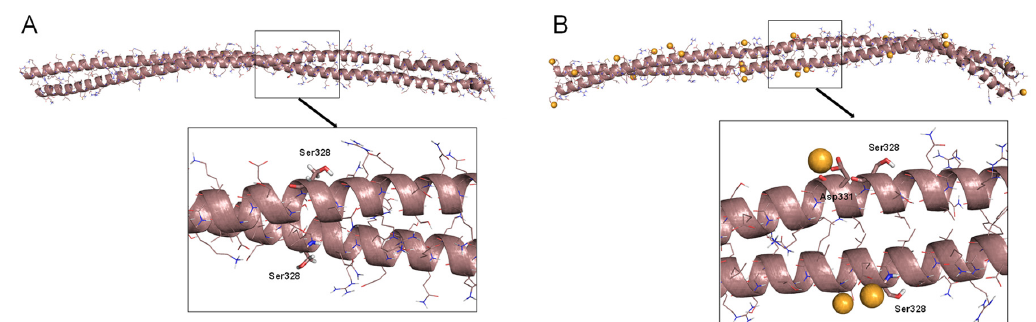
Figure 3. Dimer B of a vimentin Cys328Ser mutant and its interaction with zinc. ( A ) Final snapshot of a 100 ns MD simulation of the Cys328Ser mutant in water. ( B ) Final snapshot of 100 ns MD simulation of this mutant in the presence of zinc. In both cases, lower panels show an amplified view of the region around Ser328. Zinc atoms are represented as orange spheres.